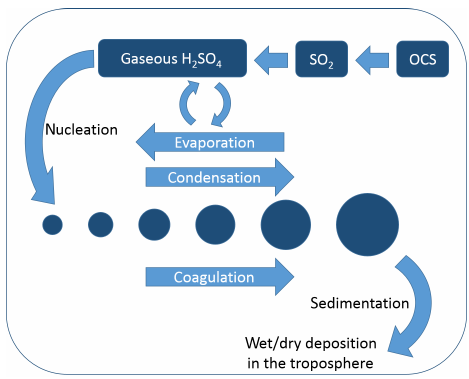
Figure 3. Schematic representation of the sulfur species and the processes affecting them that are represented in the LMDZ-S3A